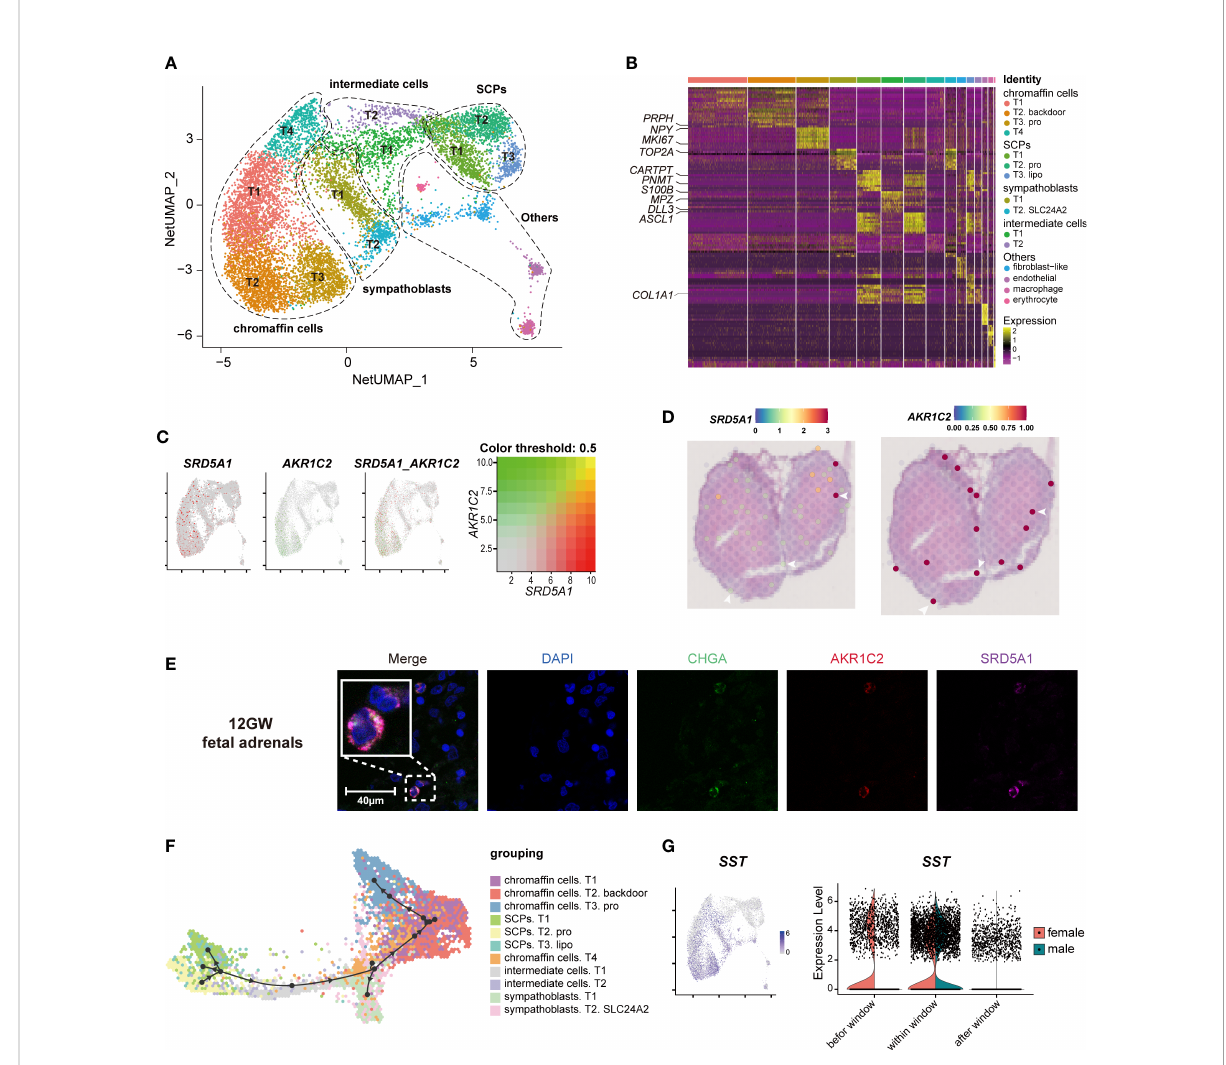
FIGURE 4 Landscape and characteristics of fetal adrenal gland neurocytes. (A) Uniform manifold approximation and projection analysis visualization of adrenal neurocytes for 10× Genomics data (n = 10,812). (B) Heatmap of the top 10 differentially expressed genes (DEGs) between adrenal neurocyte populations. Detailed cell information and DEGs can be found in Table S4. (C) Expression patterns of SRD5A1 and AKR1C2 exhibited by feature plot visualization, which are key enzymes of the DHT “ backdoor pathway ” . A gradient of gray, red, or green indicates low to high expression, and yellow indicates coexpression. (D) Visualization of the spatial transcriptome shows the locations with high expression of SRD5A1 and AKR1C2 in 8GW fetal adrenal tissues. (E) Immuno fl uorescence staining of SRD5A1 (purple), AKR1C2 (red), and CHGA (green) in fetal adrenal tissues. Scale bar, 20 m m. (F) Differentiation of the trajectory of fetal adrenal gland neurocytes using Dyno. The arrow direction indicates the trajectory of cell differentiation. (G) Feature plot visualization of SST in fetal adrenal neurocyte data, mainly expression in mature neurocytes (chromaf fi n cells and sympathoblasts). Violin plot of SST expression with sex